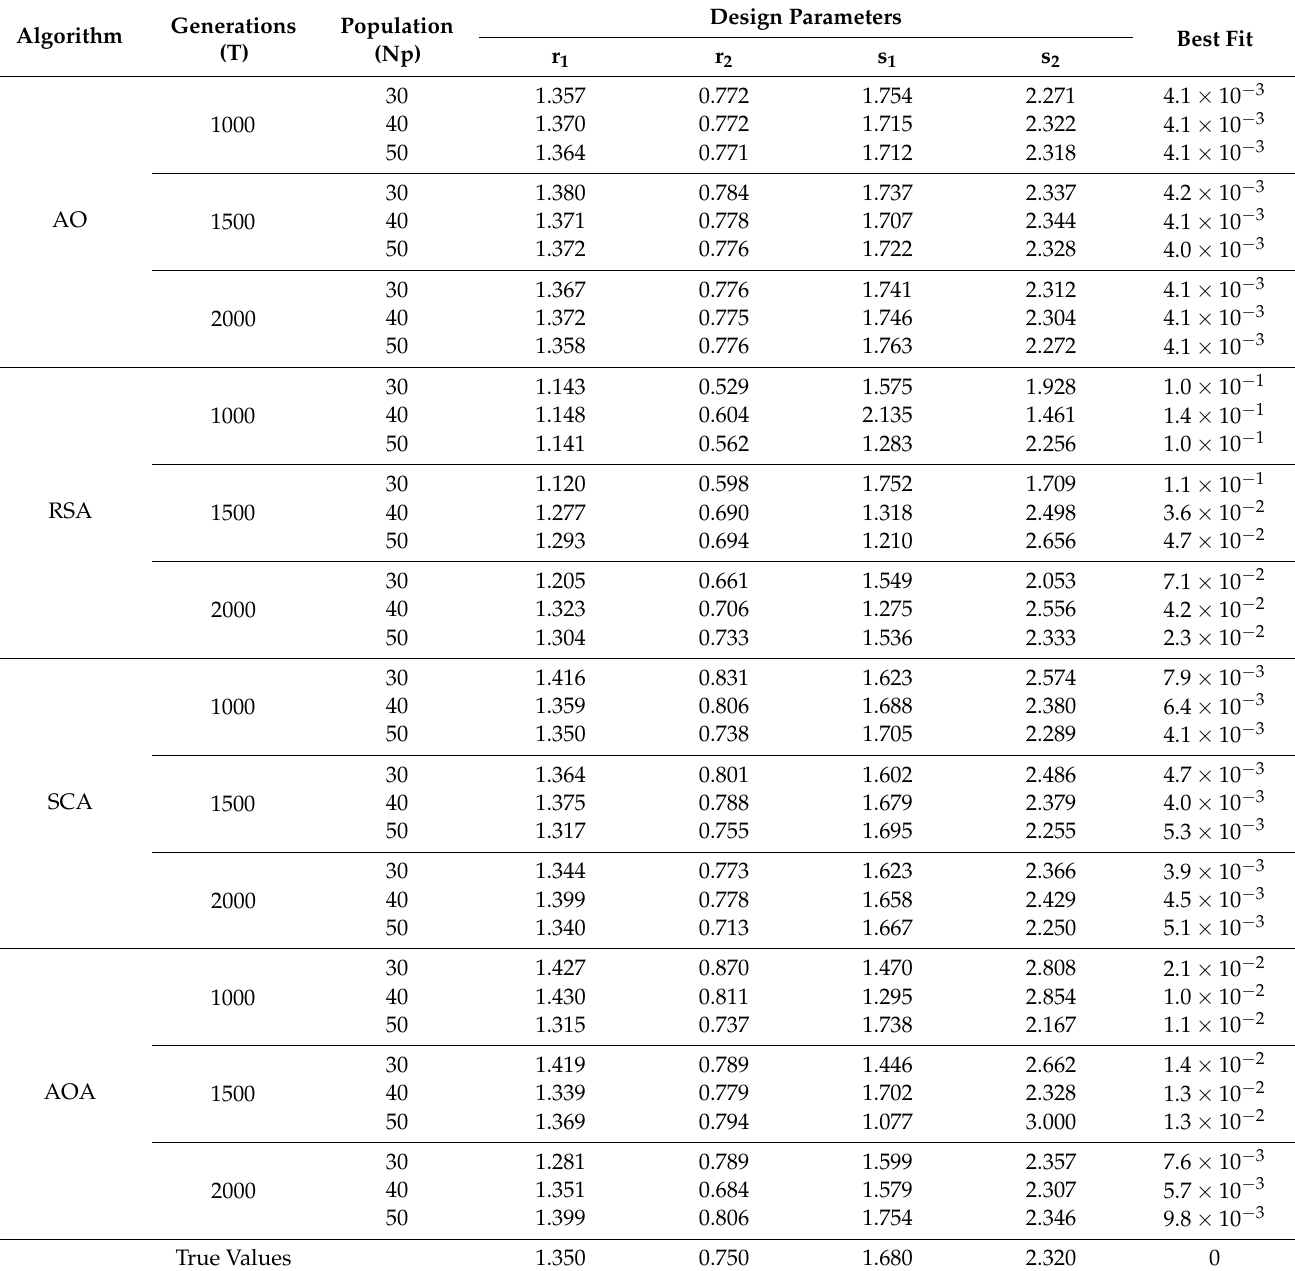
Table 17. Comparison of AO with AOA, SCA, and RSA against the true values for the CAR model at 0.08 noise